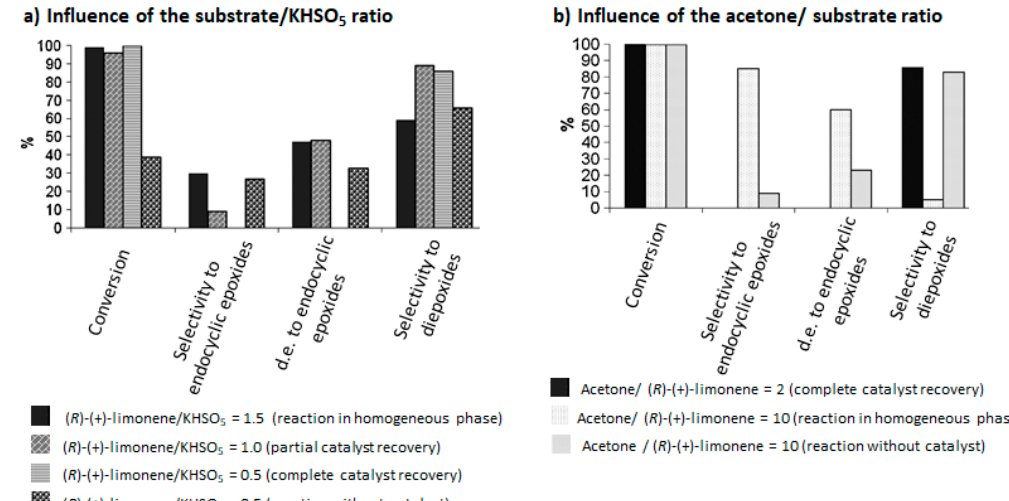
Figure 4. Influence of reaction parameters in ( R )-( + )-limonene oxidation catalyzed by Salen manganese (III) complexes (adapted from reference [22]).